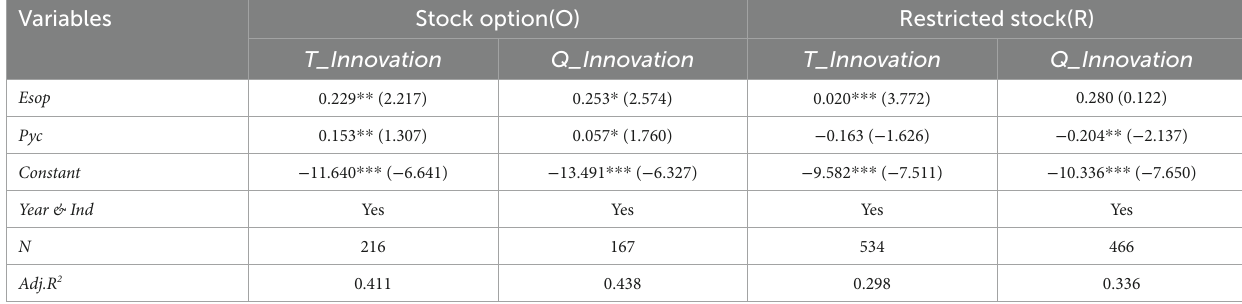
TABLE 11 Employee equity incentive forms, senior executives’ psychological capital, and enterprise innovation. Variables